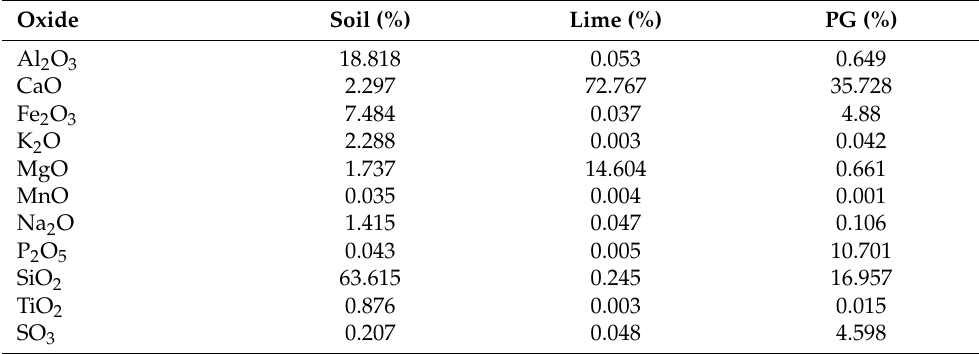
Table 2. Chemical Composition of